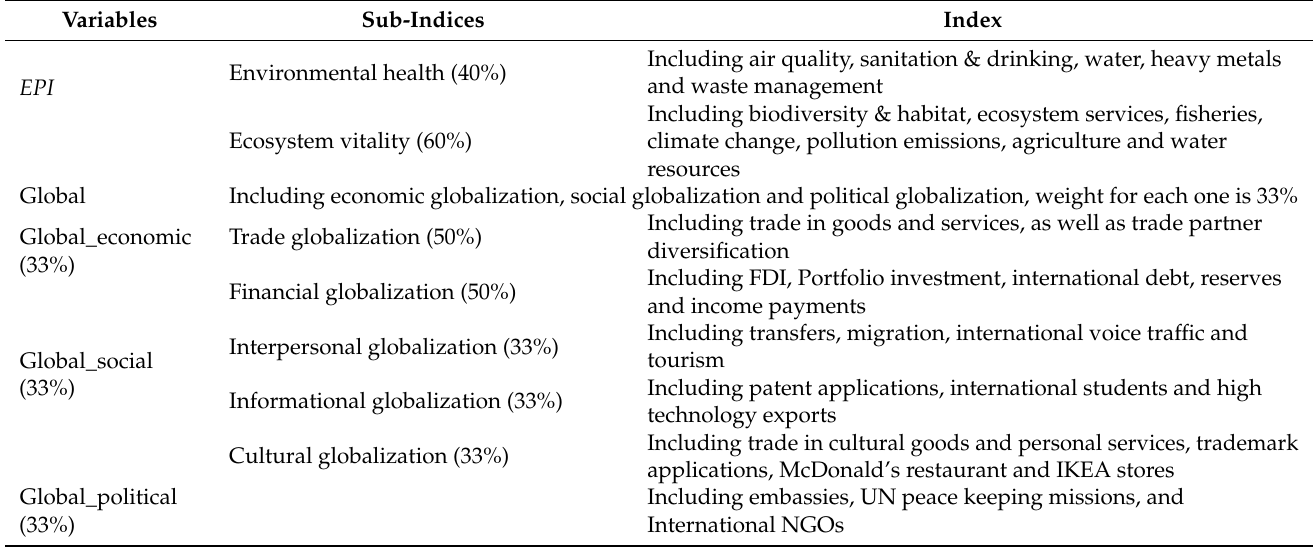
Table 1. Main description for variables of EPI and